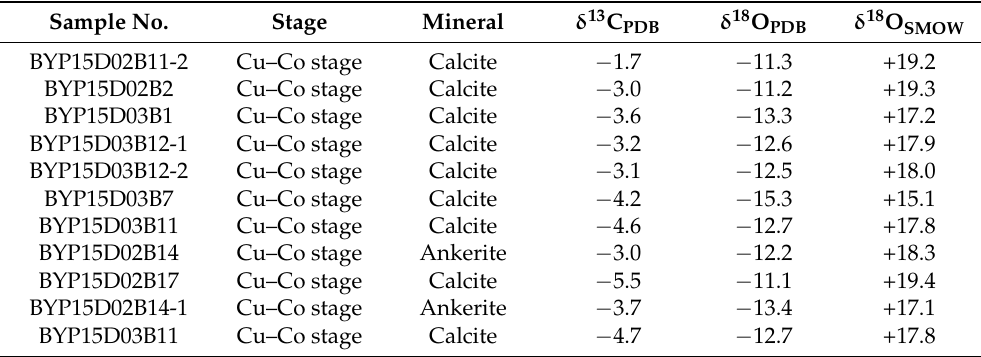
Table 1. Carbon and oxygen isotopic compositions of carbonate minerals at the Baiyangping Cu – Co – Pb – Zn deposit.